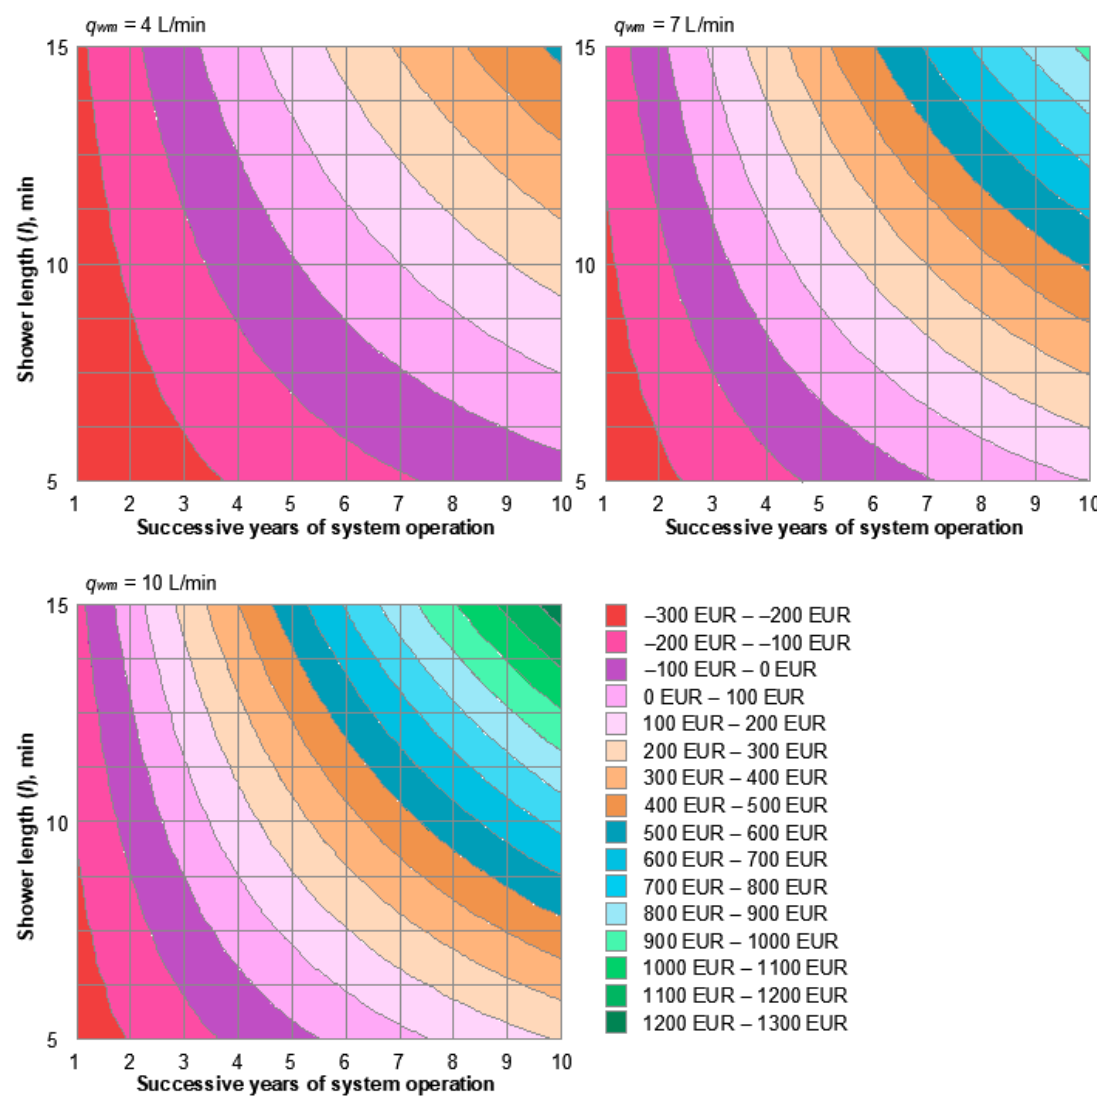
Figure 11. Net Present Value (NPV) calculation results depending on the shower length and system lifetime.